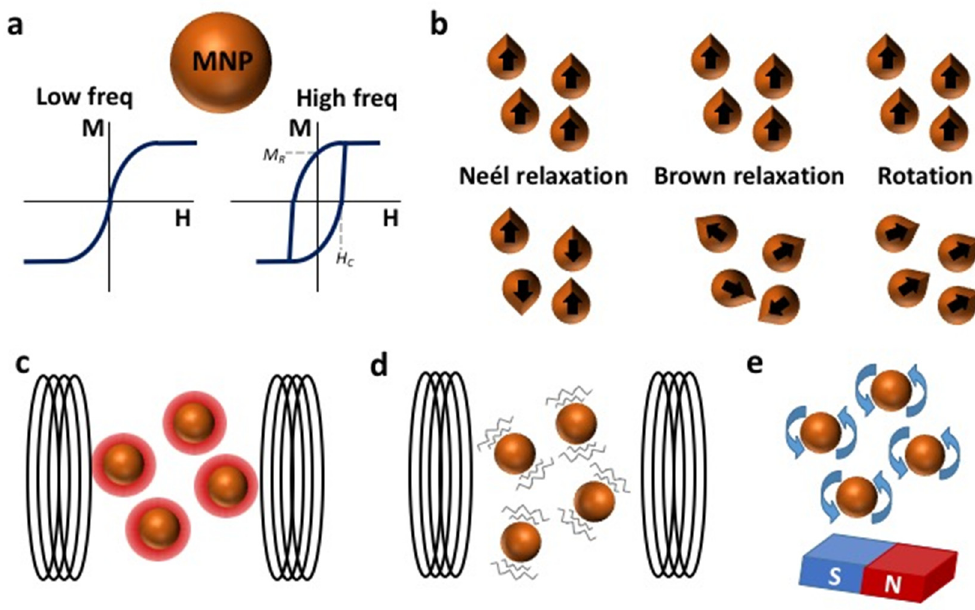
Figure 2. Physical properties of magnetic nanoparticles (MNPs), and the magnetic response to low and high frequency magnetic fields. ( a ) At low frequencies the MNPs present a S-like magnetic response with a high susceptibility (superpar- amagnetic) and they transit towards a hysteretic magnetic response when exposed to high frequency AMFs. ( b ) The MNPs may lose spontaneously their magnetization by Néel and Brownian relaxation when the applied field is subtracted or rotate coherently in response to a rotatory magnetic field. Through these mechanisms the MNPs can convert the energy of magnetic fields into ( c ) heat, ( d ) mechanical vibration or ( e ) local torque in the cell environment depending on the features of the field applied.